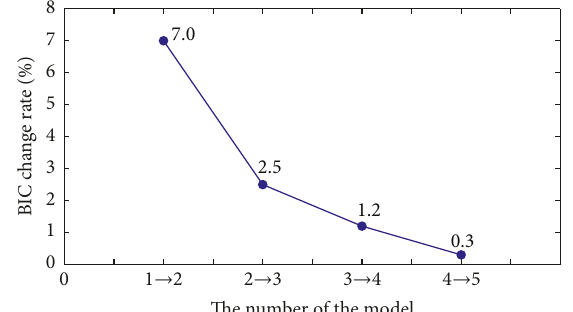
Figure 7: The matrix damage crack.